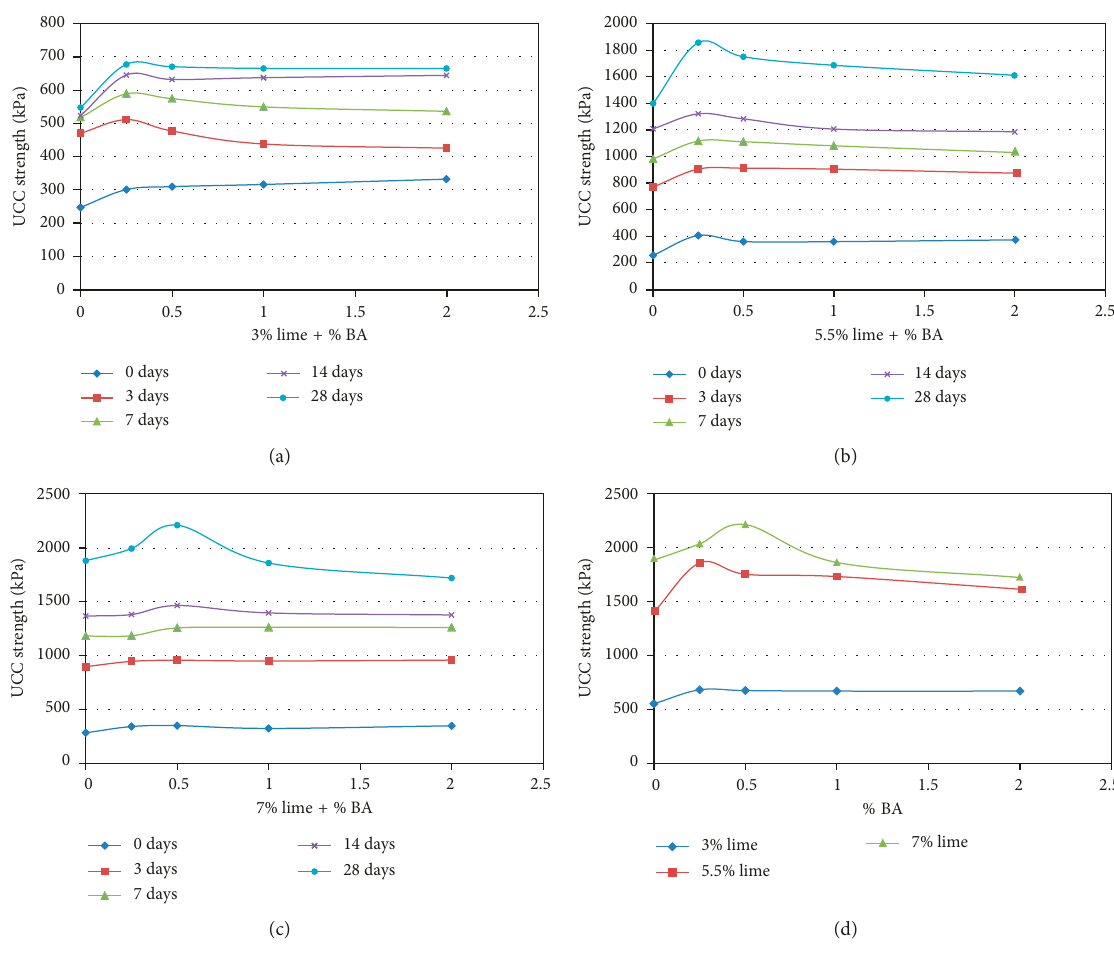
Figure 5: Variation of UCS with % BA for lime stabilized soil: (a) 3%, (b) 5.5%, (c) 7%, and (d) 28-day UCS